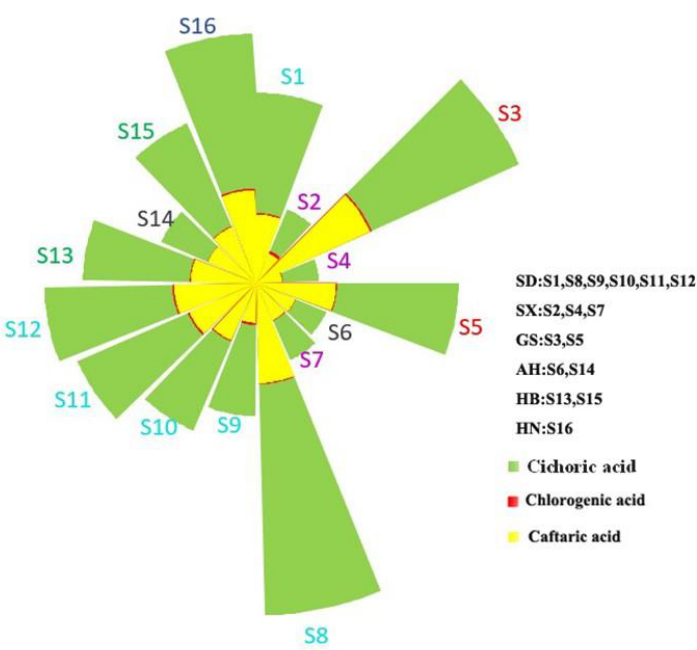
Table 5. Contents of 3 components in samples of Echinacea pupurea (L.) Moench from different ori- gins ( n = 3, mg/g). Figure 6. Cumulative sum of the contents of three phenolic acids in 16 batches of Echinacea pupurea (L.) Moench.